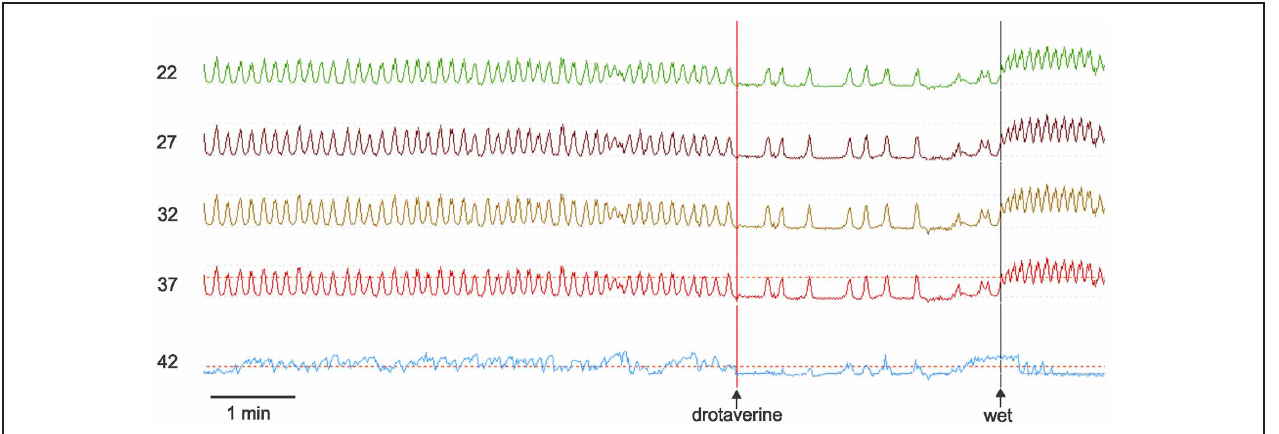
FIGURE 1 | Manometry tracings of the achalasia patient. Rhythmic simultaneous contractions occur at 7/min. Drotaverine inhibits the frequency without changing the amplitude. Drotaverine was given about 1min before the vertical line was placed on the recording. A subsequent wet swallow (wet) markedly increased the frequency. The numbers at the left are the